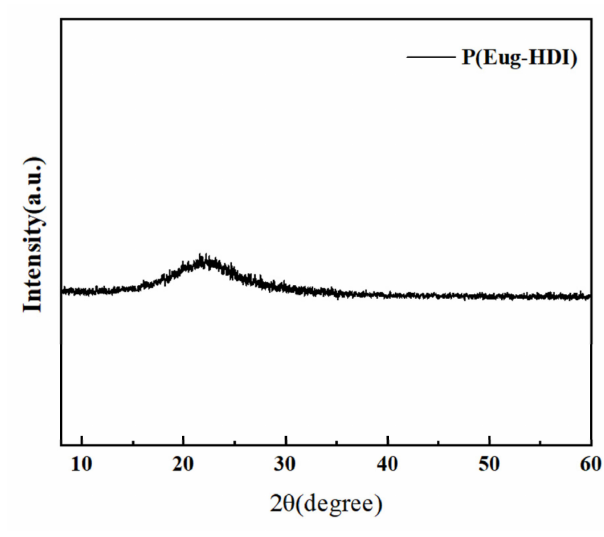
Figure 7. X-ray diffraction spectrum of P(Eug-HDI).